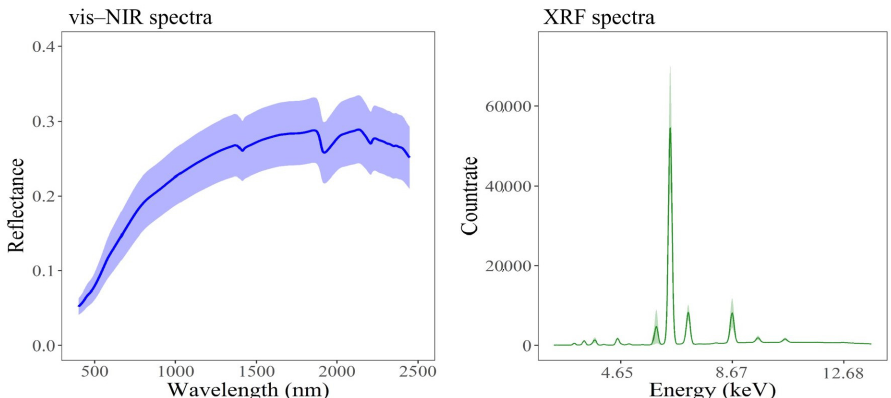
Figure 4. Representative soil mean spectra (bold lines) and their variance (shaded areas) of vis–NIR and